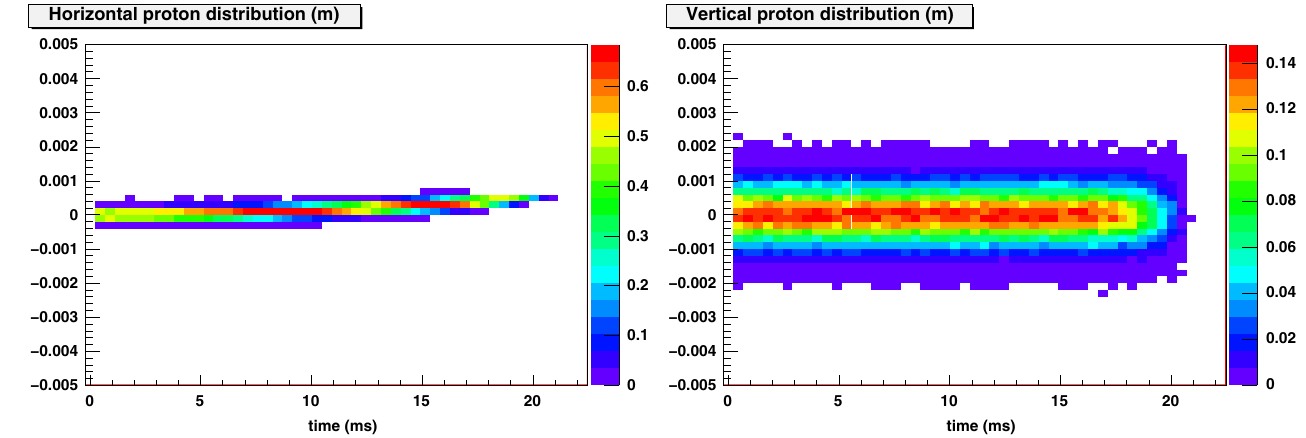
FIG. 12. (Color) The horizontal and vertical proton distribution at the TOTEM roman pots as a function of time, for a quench in MB.B12L5.B1 and resulting circuit decay in RB.A45. The calculation was made for a 7 TeV stored beam with nominal collision optics. The color scale shows, in arbitrary units, the particle density in the